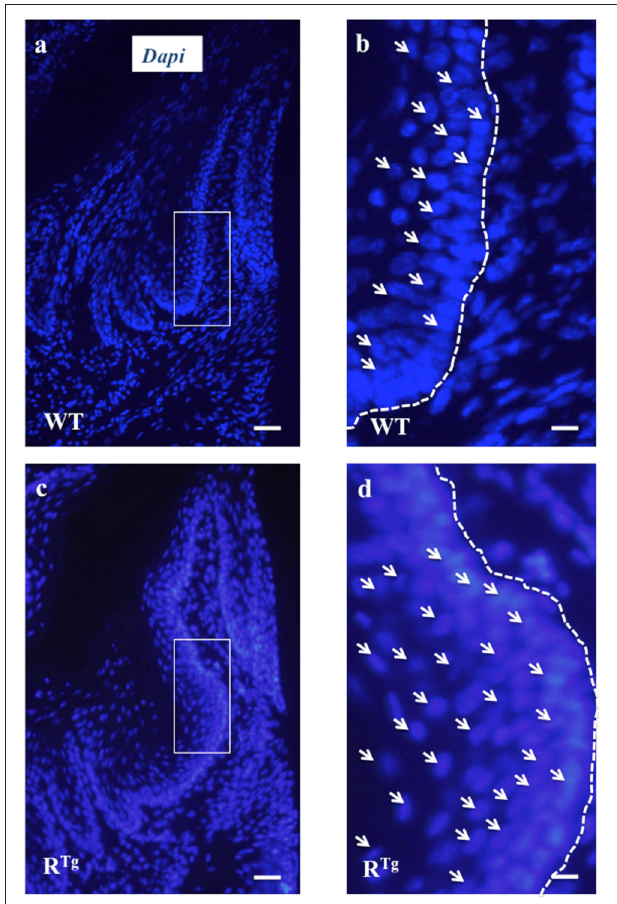
FIGURE 5 | Evidence of gingival epithelium hyper-cellularity in R Tg mice based on numbering of DAPI stained cell nucleus. Enlargement view of similar region of the gingival epithelium (rectangles in a,c ) evidenced a two times augmentation of the number of cells (arrows) in the gingival epithelium of R Tg mice comparatively to WT mice (b,d) . Scale bars in A,C correspond to 100 µ m and in b,d to 25 µ